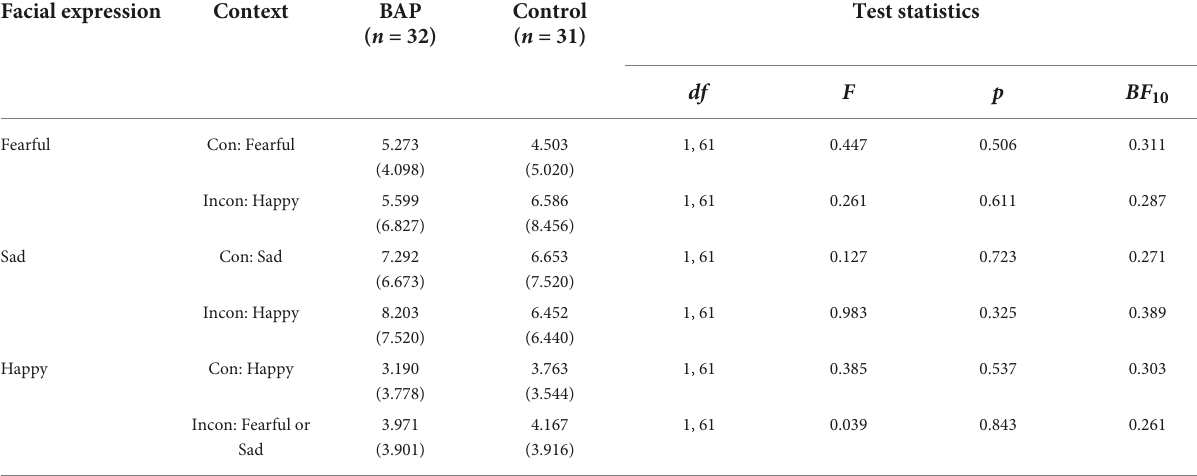
TABLE 3 Mean (SD) of error rate under each emotion and congruence condition for the groups. Facial